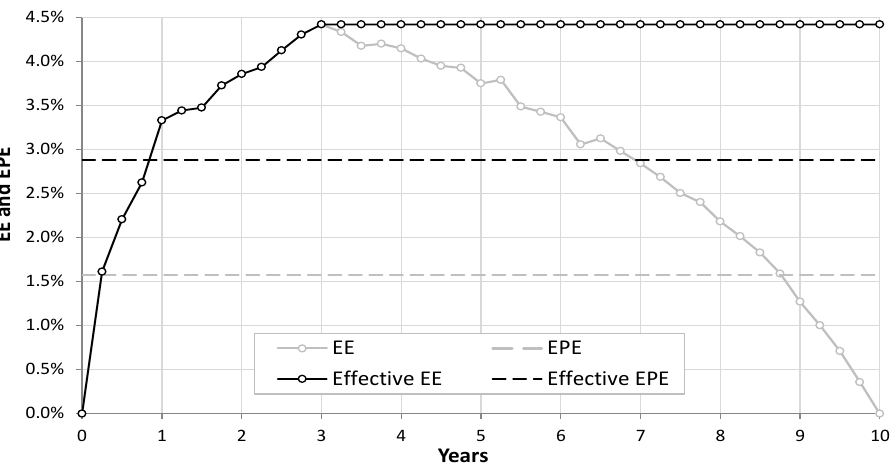
Various relevant exposure measures based on a single simulation of possible future exposures of a 10 year interest rate swap